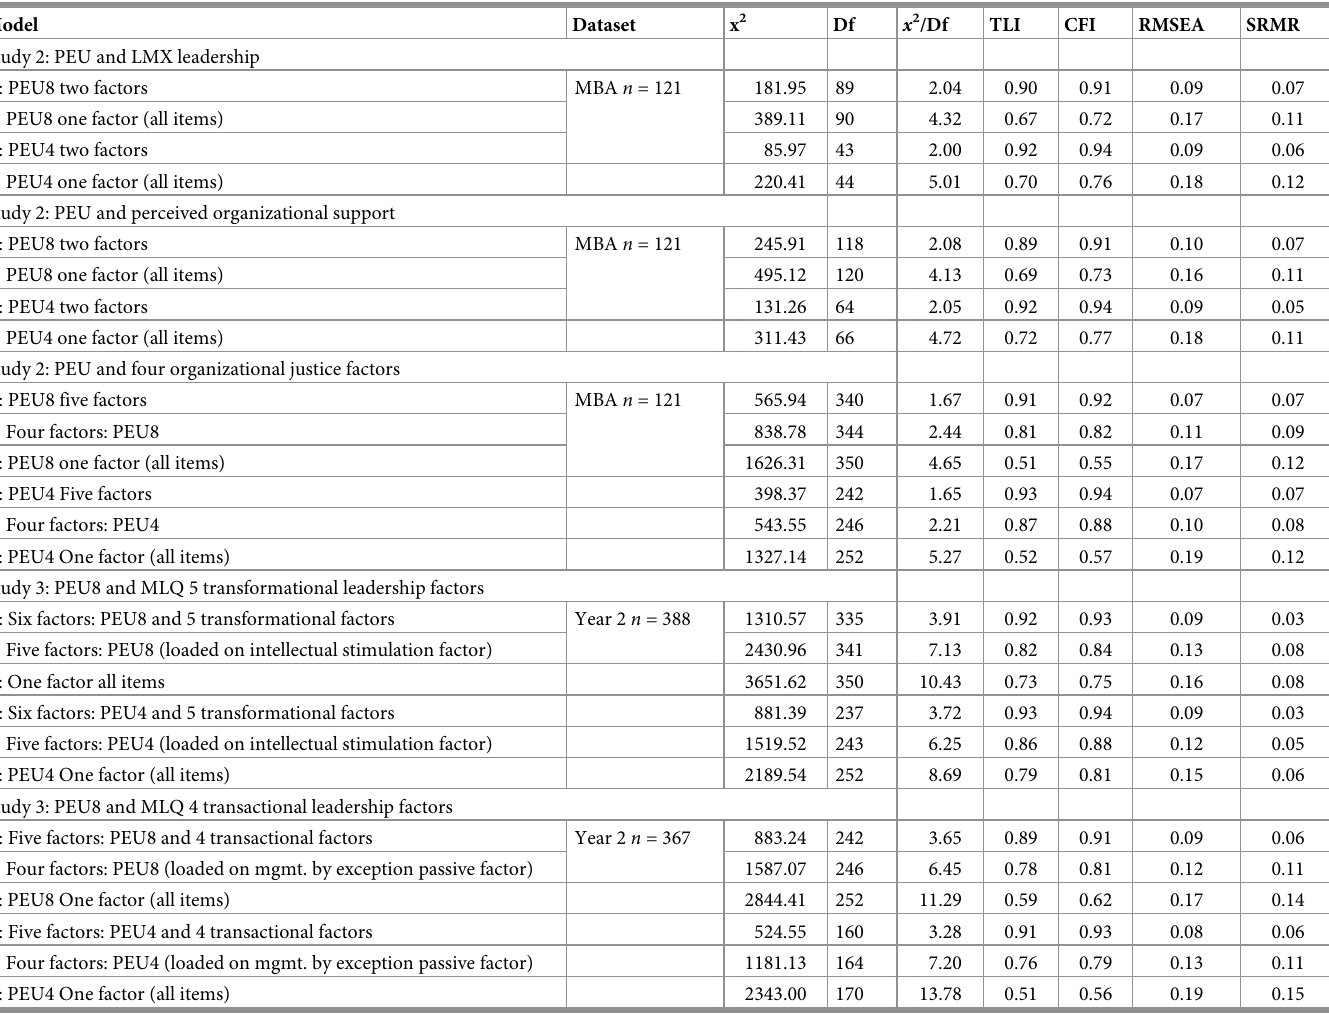
Table 5. Fit statistics for discriminant validity LMX, POS, OJ and MLQ (Studies 2 and 3).